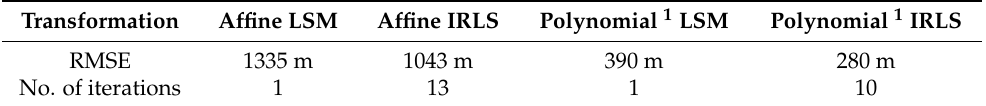
Table 1. Results of